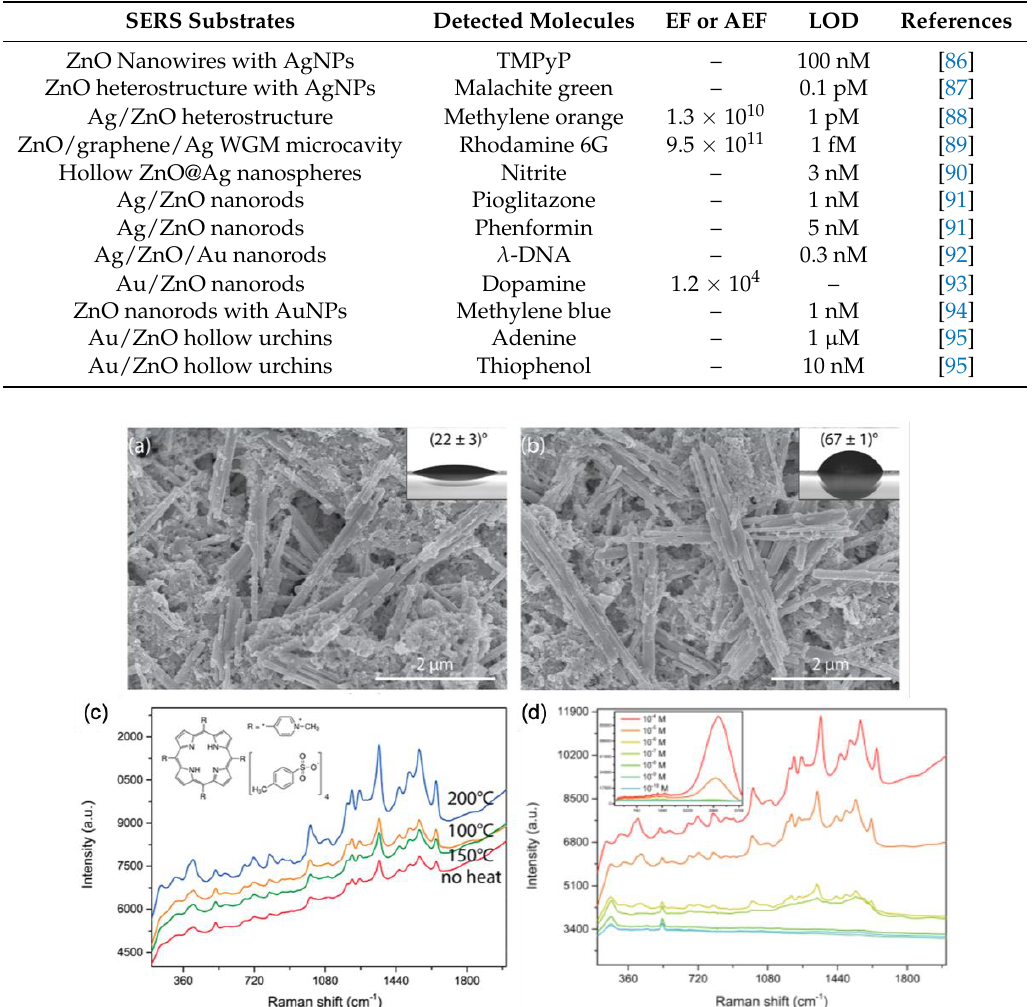
Table 3. SERS performances of metal-ZnO-based nanostructures for biological/chemical sensing (AgNPs = Ag nanoparticles; TMPyP = (meso-tetra(N-methyl-4-pyridyl)porphine tetrachloride; WGM = whispering gallery mode).